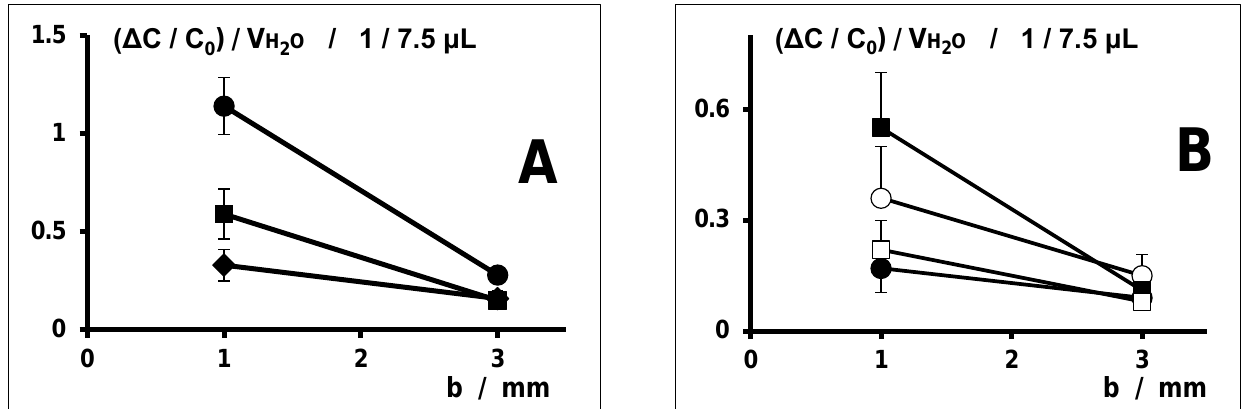
Figure 6. Relative water-specific change in electrical capacitance (ratio of the relative change in elec- trical capacitance to the causal change in water volume) (ΔC/C 0 )/V H 2 O of dressing samples (A: series D; B: series S) as a function of the stitching spacing b (the values correspond to those in Figures 4 and 5): ( A ) Sensor wire spacing a = 1 mm; Sensor wire diameter d = 0.071 mm— , d = 0.140 mm— , d = 0.210 mm— ; ( B ) Sensor wire diameter d = 0.071 mm; Sensor wire spacing a = 0.5 mm— , a = 1 mm— , a = 1.5 mm— , a = 2 mm— .